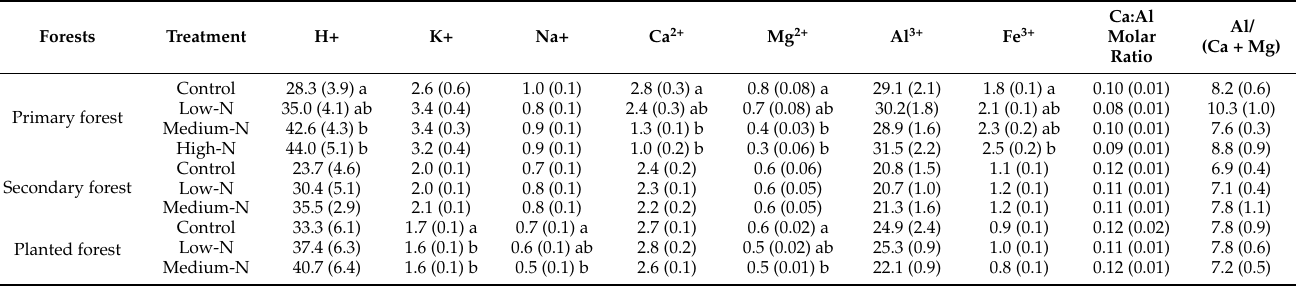
Table 3. Soil exchangeable cation concentrations, Ca:Al molar ratio and Al/(Ca + Mg). Unit is mmol kg − 1 dry soil. Different lower case letters indicate significant difference between treatments in each forest (One-way ANOVA, LSD test, p <